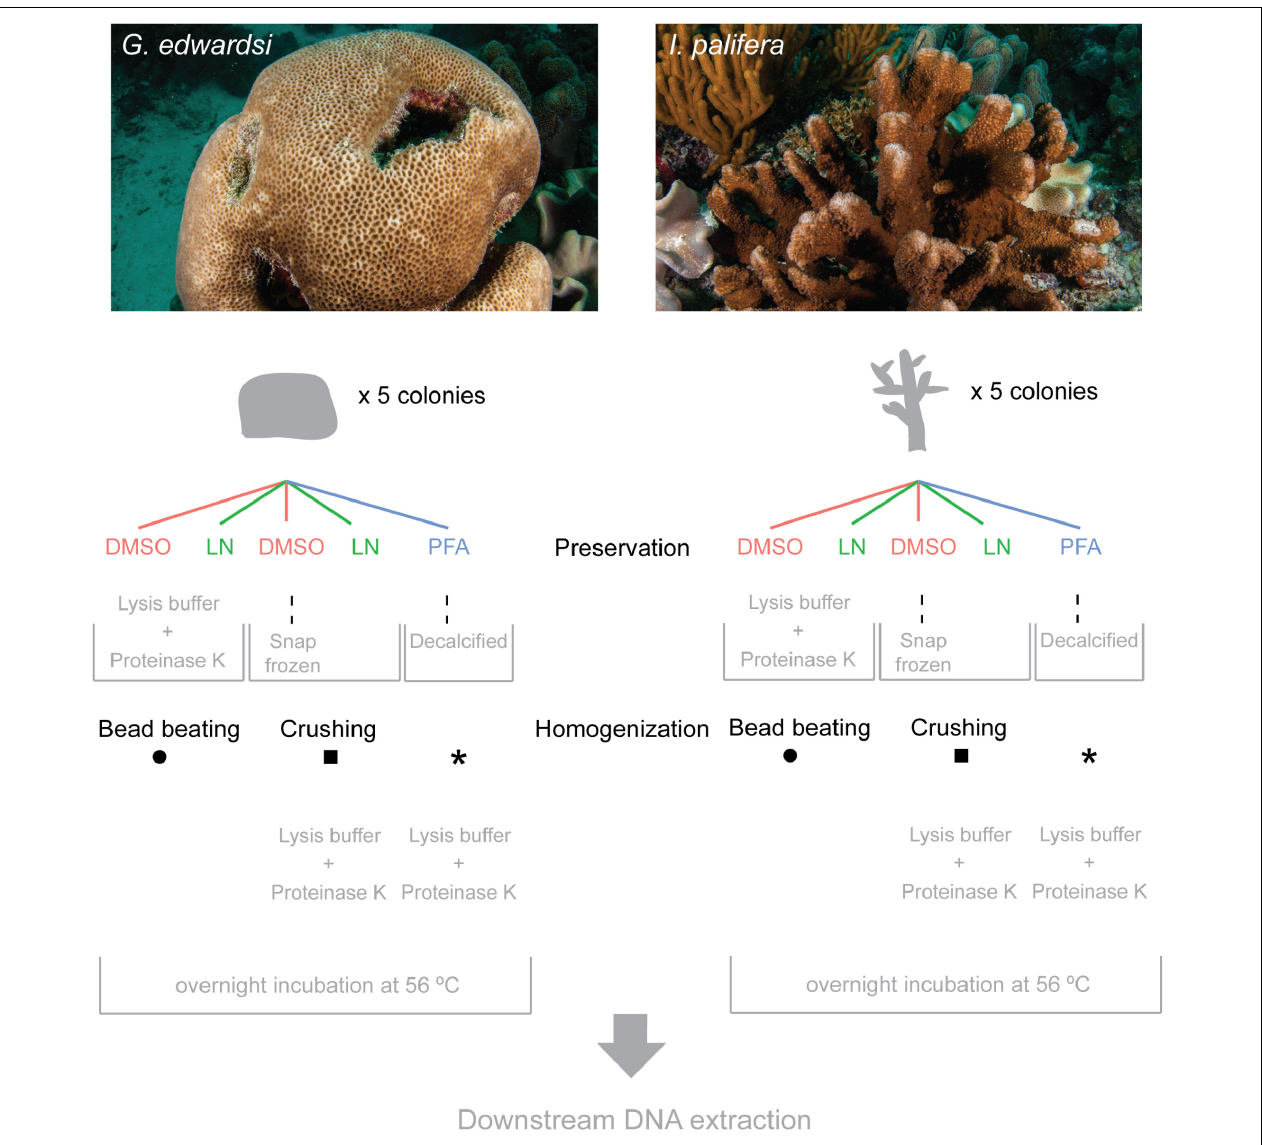
FIGURE 1 | Flow diagram of experimental design. Five fragments were collected per colony; two were preserved in DMSO, two in LN and one in PFA. PFA-preserved fragment was decalcified before DNA extraction. One fragment per each preservation method was homogenized using either bead beading or crushing method. LN, liquid nitrogen; DMSO, salt saturated dimethyl sulfoxide (DMSO) – EDTA; PFA, paraformaldehyde. Photos by Ed